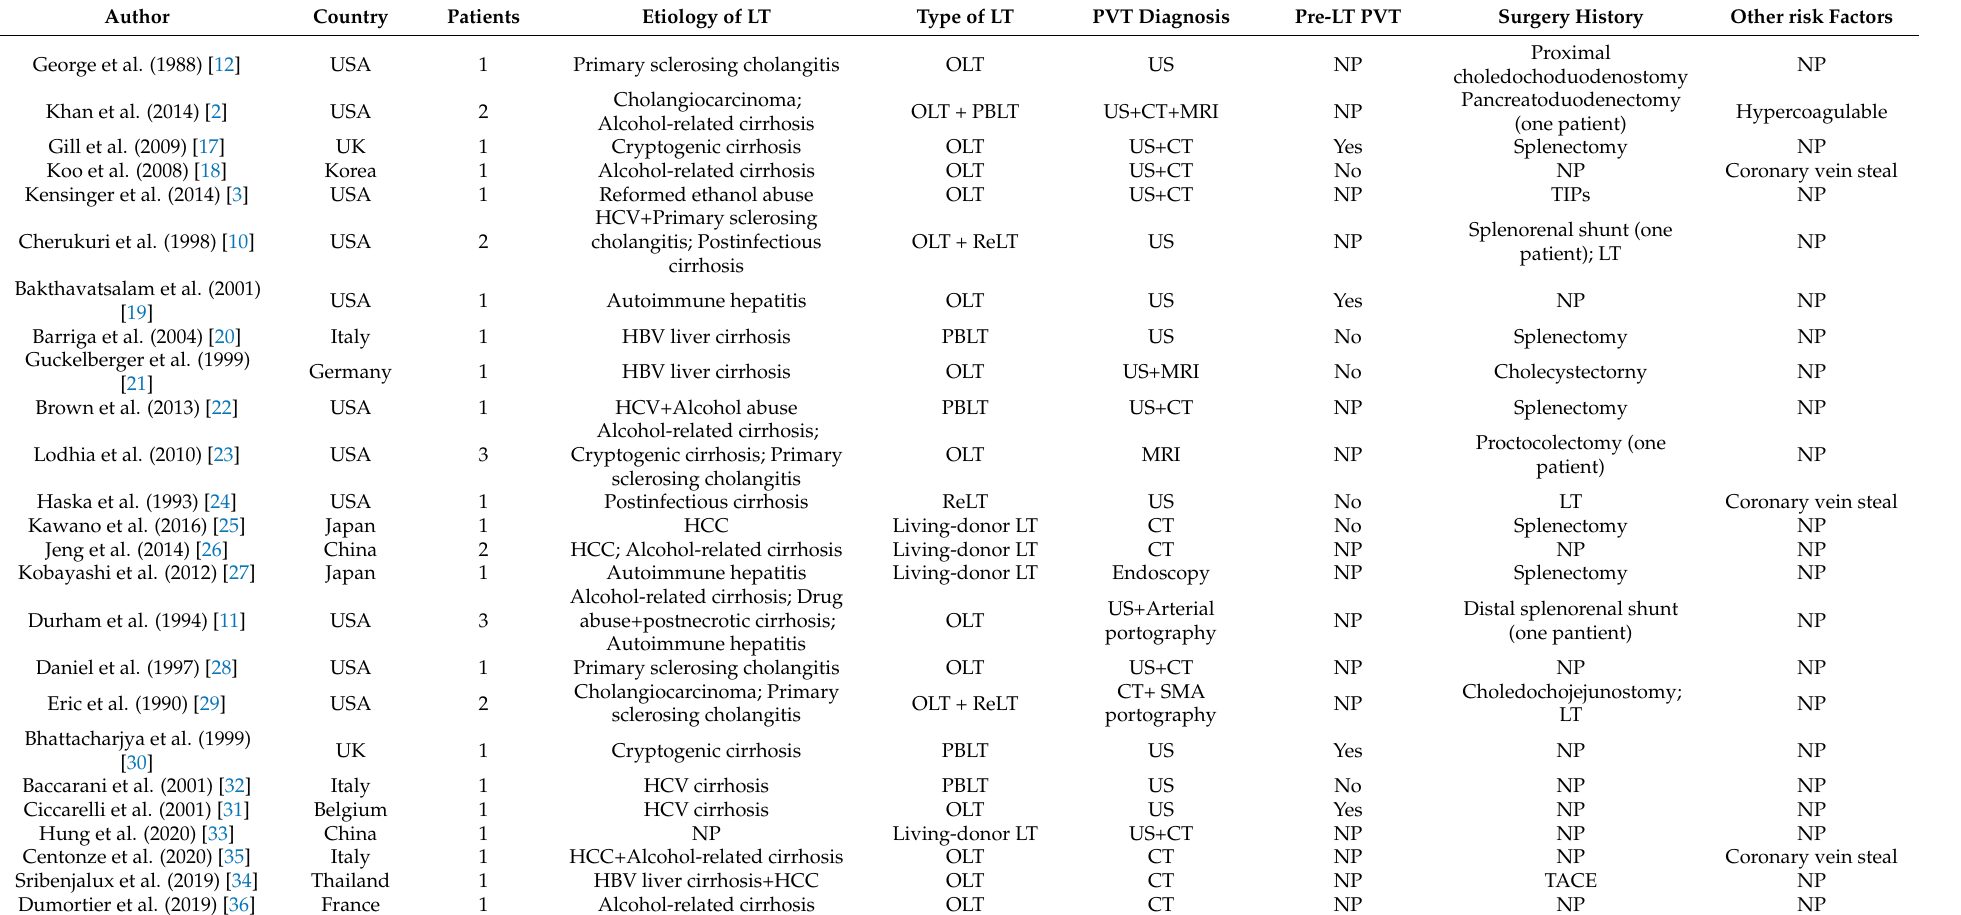
Abbreviations: LT, liver transplantation; OLT, orthotopic liver transplantation; ReLT, retransplantation; PBLT, piggyback liver transplantation; HCV, hepatitis C virus; HCC, hepatocellular carcinoma; US, ultrasonography; CT, computed tomography; MRI: magnetic resonance imaging; SMA, superior mesenteric artery; PVT, portal vein thrombosis; TACE, transarterial chemoembolization; NP, not